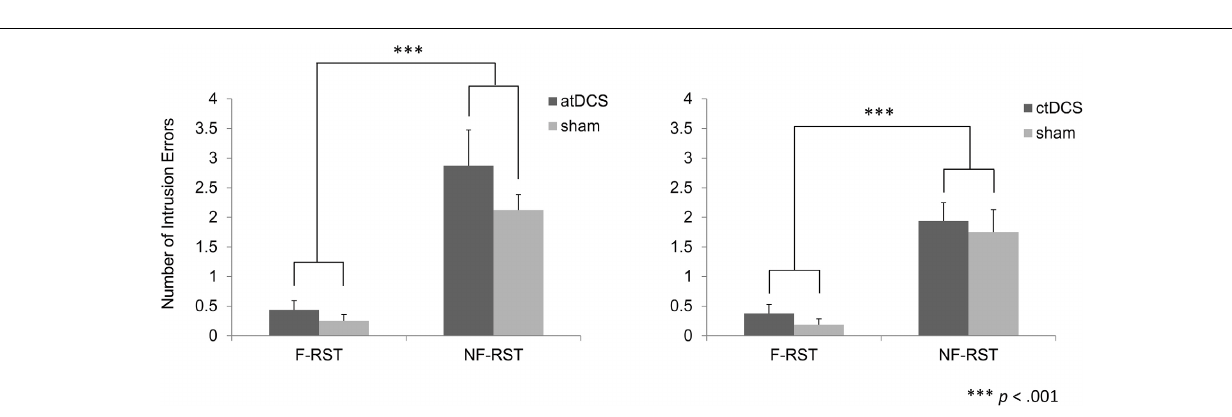
interaction between factors was also non-significant [ F (1 , 15) = 0 . 81, p > 0 . 05].